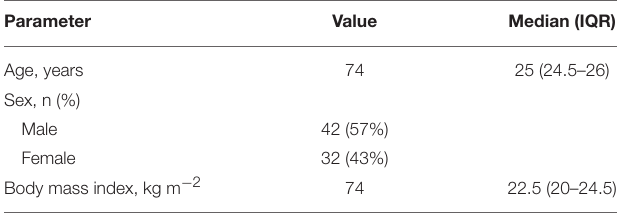
TABLE 1 | Demographic characteristics of the participants.